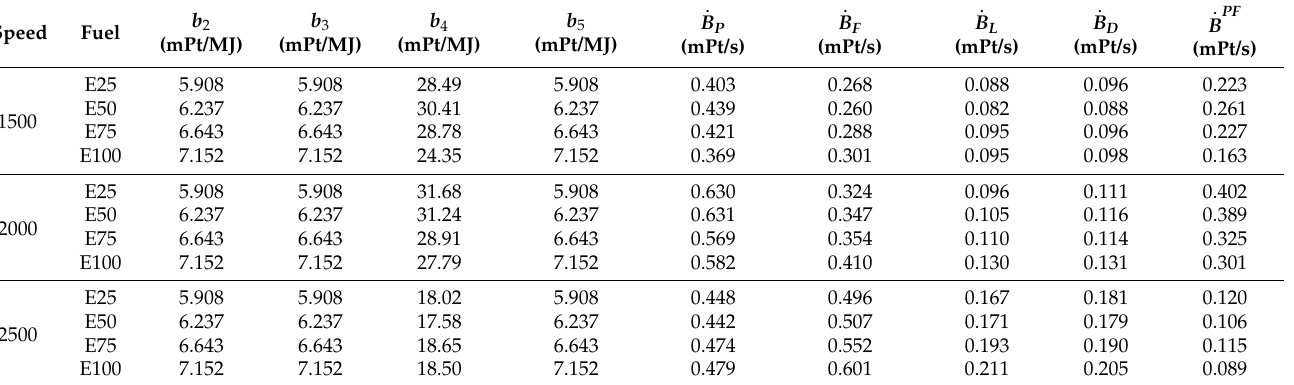
Table 7. Exergoenvironmental